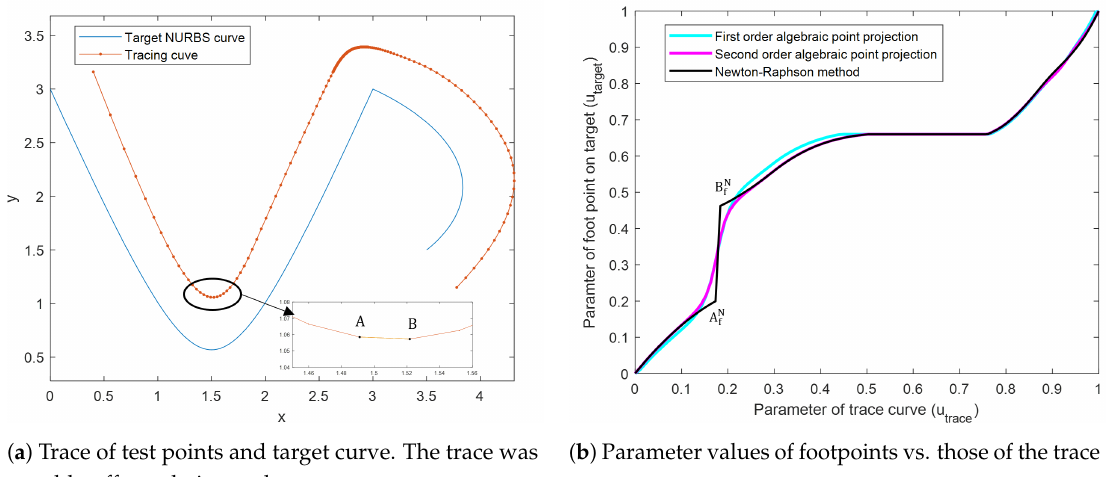
Figure 17. Relative error values of footpoints obtained using the Newton–Raphson method and the algebraic point projection respectively.